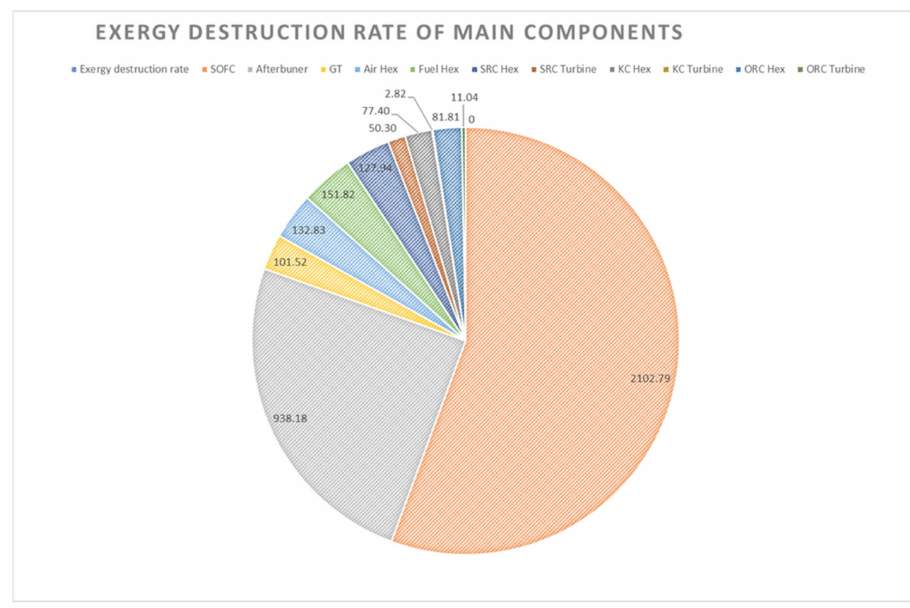
Figure 5. Exergy destruction rates of the main components of the present